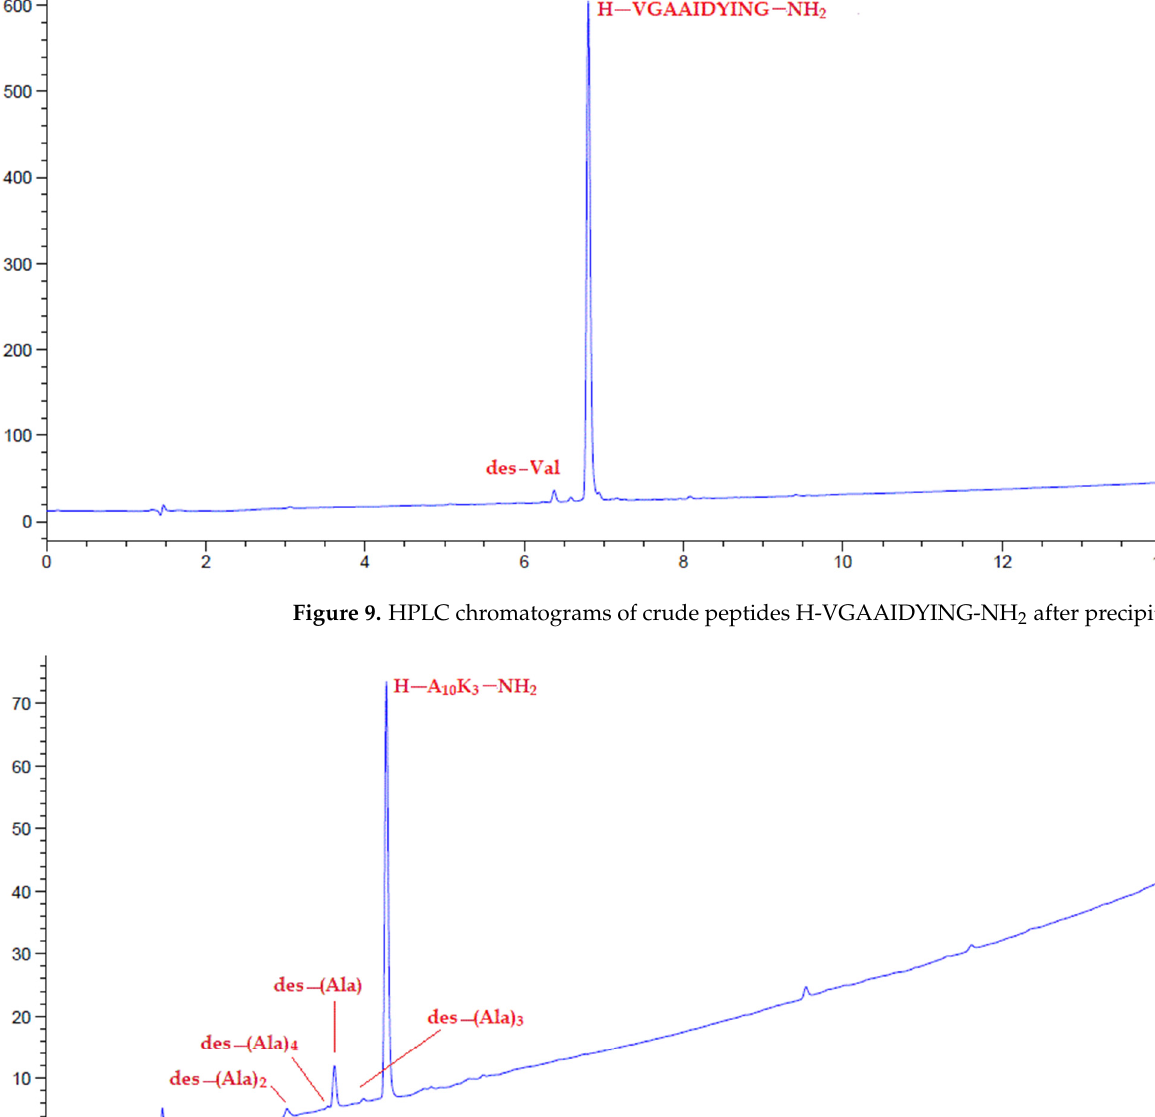
12 of 16 Figure 8. HPLC chromatograms of crude peptides H-RGDfK-NH 2 after precipitation.